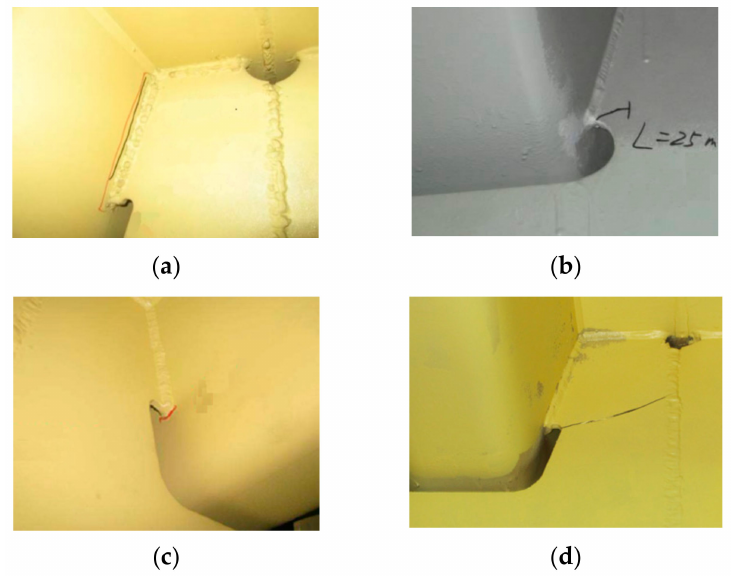
Figure 1. Observed fatigue cracks at ( a ) RF-R; ( b ) RF-F; ( c ) RF-W; ( d )